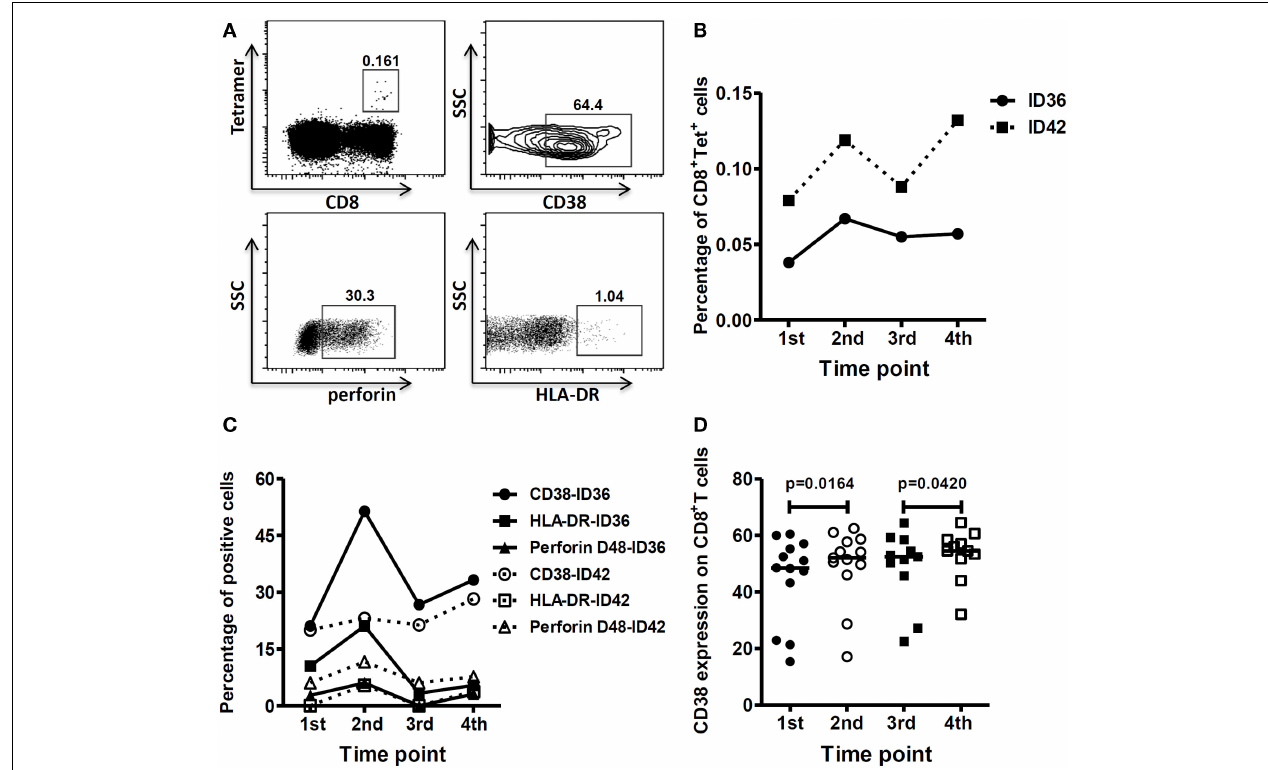
activation markers (CD38 and HLA-DR) and cytolytic marker (Perforin D48) on HLA-A*0201 M1 58–66 tetramer positive cells before and after each vaccine dose. Lines represent the percentage of tetramer positive cells with the noted markers. (D) Comparison of CD38 expression on CD8 + T cells before and after each vaccine dose in the vaccine virus-infected group (first vaccination: n = 13; second vaccination: n = 11). p- Values were calculated using the Wilcoxon matched-pairs signed rank test. For the scatter dot plots, the line represents the median